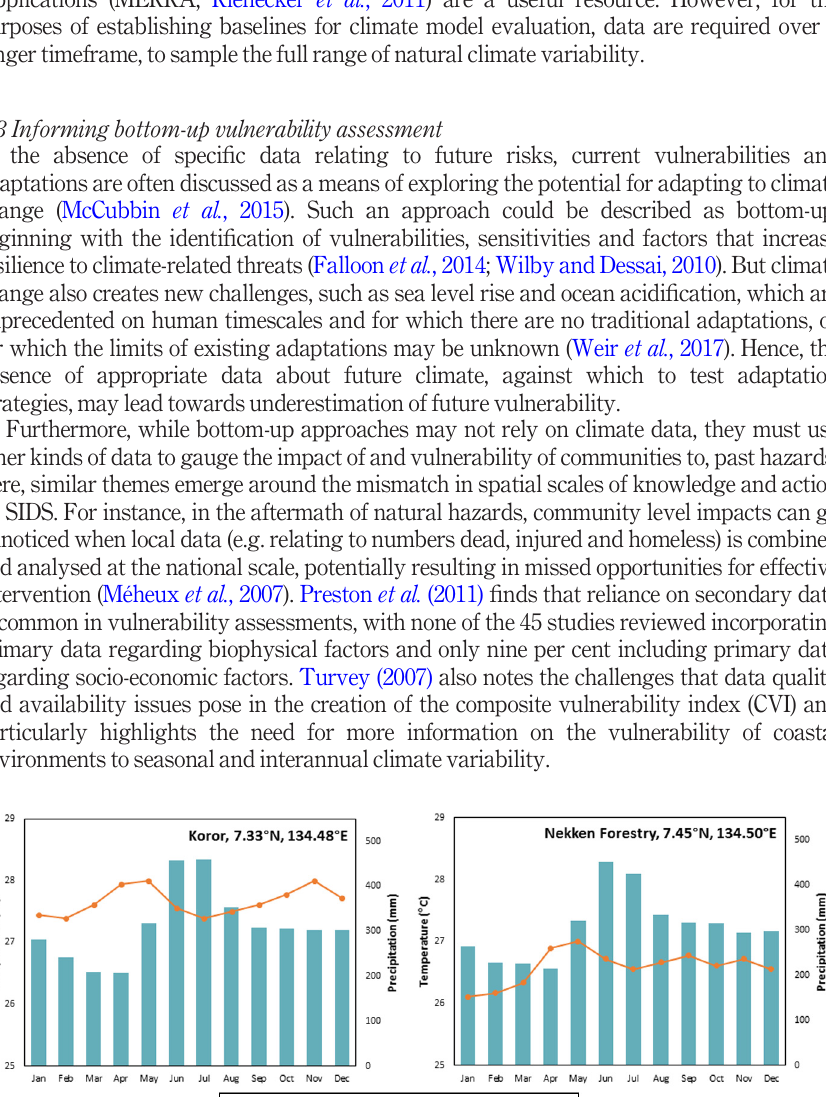
Figure 2. 1981-2010 climatological averages for rainfall and average temperature at two sites in